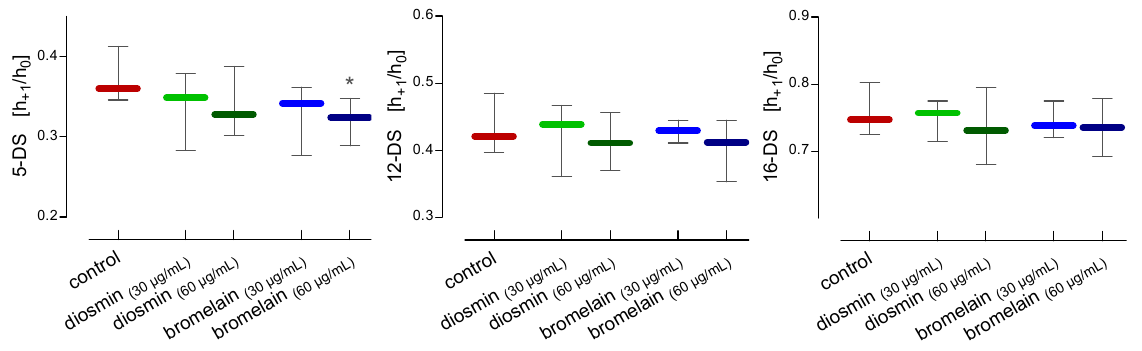
Figure 6. Alterations in the h +1 /h 0 parameters of 5-, 12-, and 16-doxy-stearic acid incorporated into the erythrocyte’s lipid membranes after 24 h of incubation with diosmin or bromelain. The data were expressed as the median with an interquartile range, n = 11. Statistical significance: * p < 0.05 vs. control.